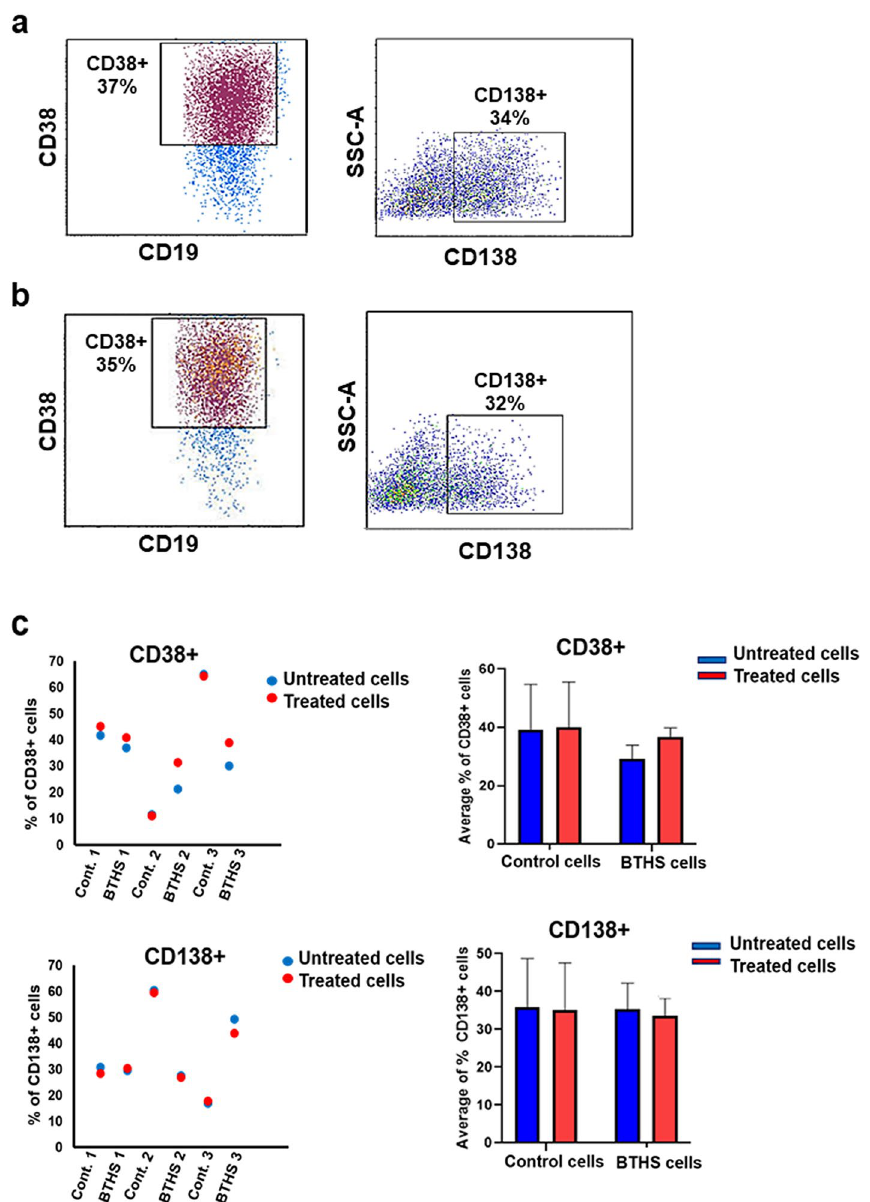
Figure 2. CD38 + and CD138 + surface markers expression in Epstein-Barr virus transformed human age- matched control and BTHS lymphoblasts after LPS stimulation. The expression of CD38 + and CD138 + surface markers were determined in control and BTHS lymphoblasts after stimulation without or with 10 µg/ml LPS using flow cytometry as described in “Materials and Methods”. ( a ) Representative flow cytometry images of CD38 + and CD138 + surface markers in control cells after LPS stimulation. ( b ) Representative flow cytometry images of CD38 + and CD138 + surface markers in BTHS cells after LPS stimulation. ( c ) Histograms showing percentage of CD38 + and CD138 + surface markers expression in LPS treated control and BTHS cells compared to untreated control and BTHS cells. N =